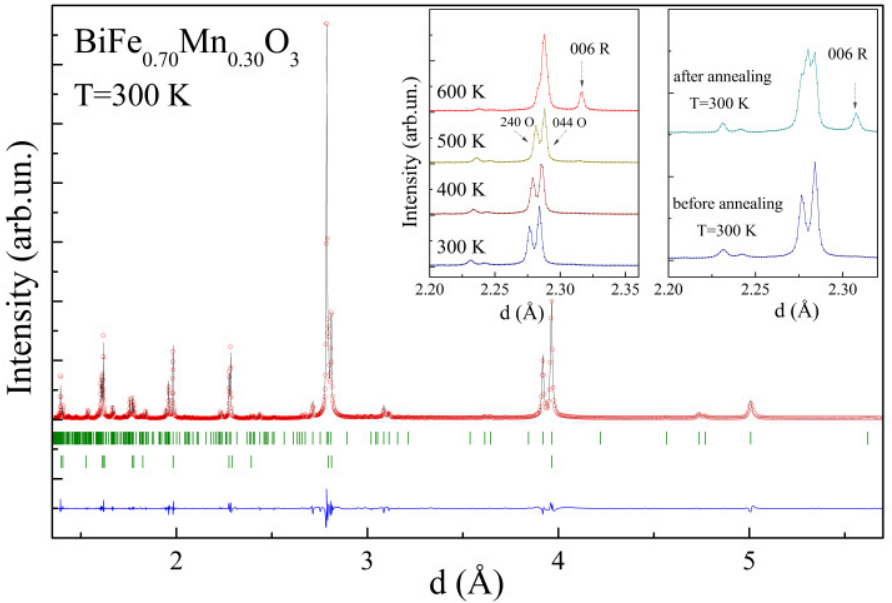
Figure 1. Room-temperature synchrotron diffraction pattern of BiFe 0.7 Mn 0.3 O 3 . The left inset shows temperature-driven changes of the reflections attributed to the different structural phases (O— Pnma phase; R— R3c phase), and the right inset shows specific reflections at room temperature for the compound before and after annealing at ~650 K.